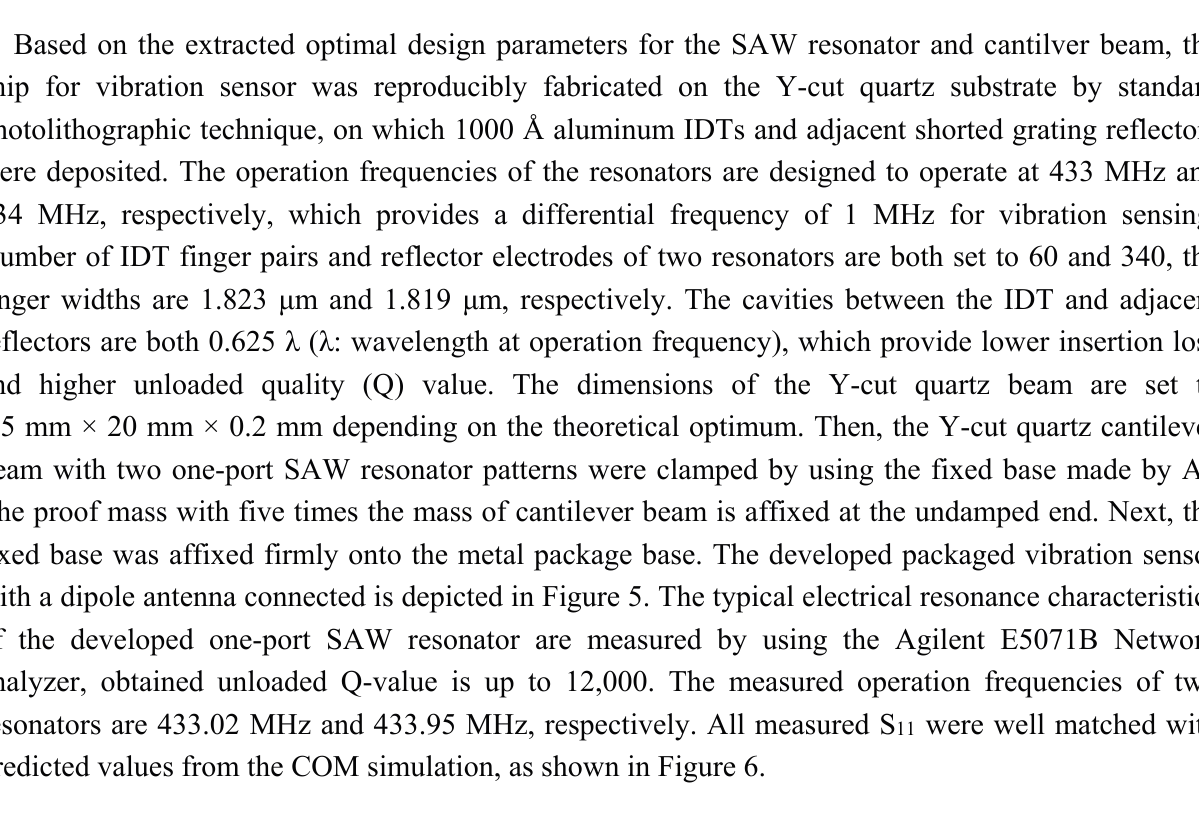
Figure 5. The wireless measurement setup of the SAW vibration